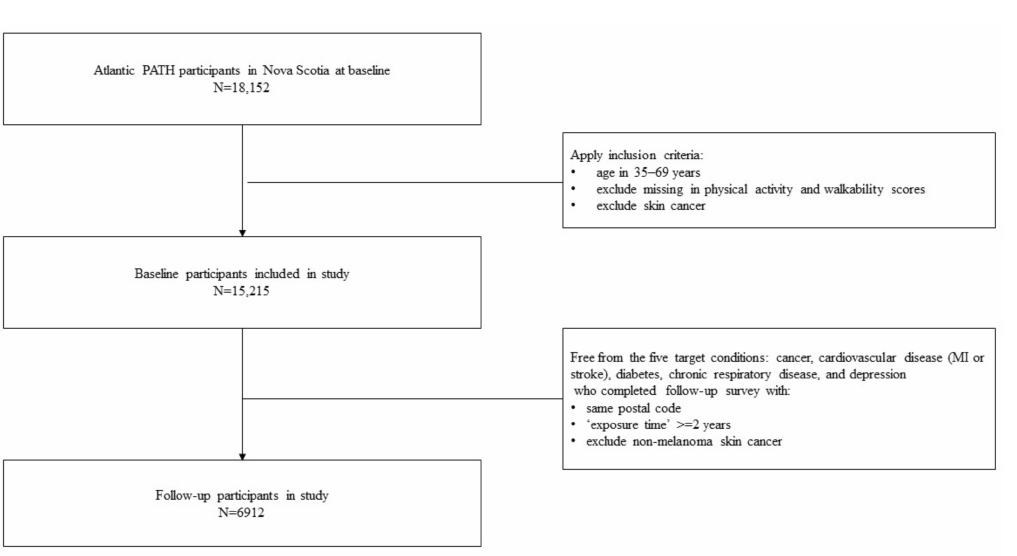
Figure 1. Participant data